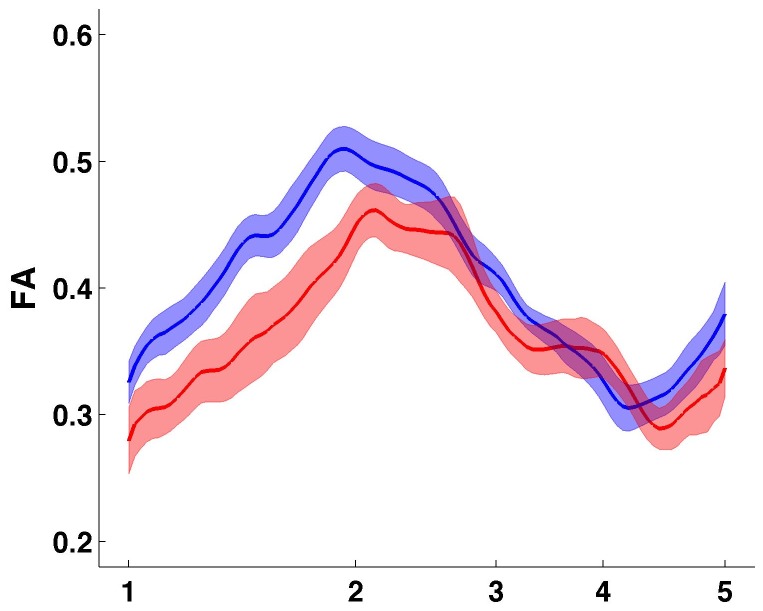
Quantitative Tractography Evaluation of the cingulum bundle.Graphical representation of the Quantitative Tractography Evaluation (QuTE) of the cingulum bundle. Y-axis: fractional anisotropy (FA) of the left and right cingulum bundle (mean). Red color: patients with behavioral variant frontotemporal dementia, blue color: healthy controls. The central line represents the mean, fields indicate +/- 1 standard error. X-axis refers to the numbers of the anatomical landmarks used to subsegment the cingulum bundle (see Figure 1 and Material and Methods).